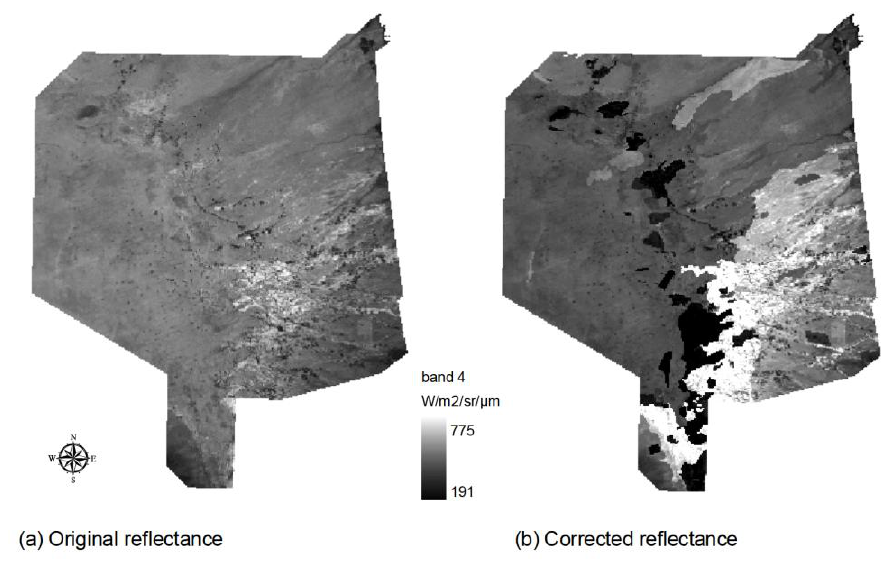
Figure 4. Comparison of reflectance (a) before and (b) after correction.